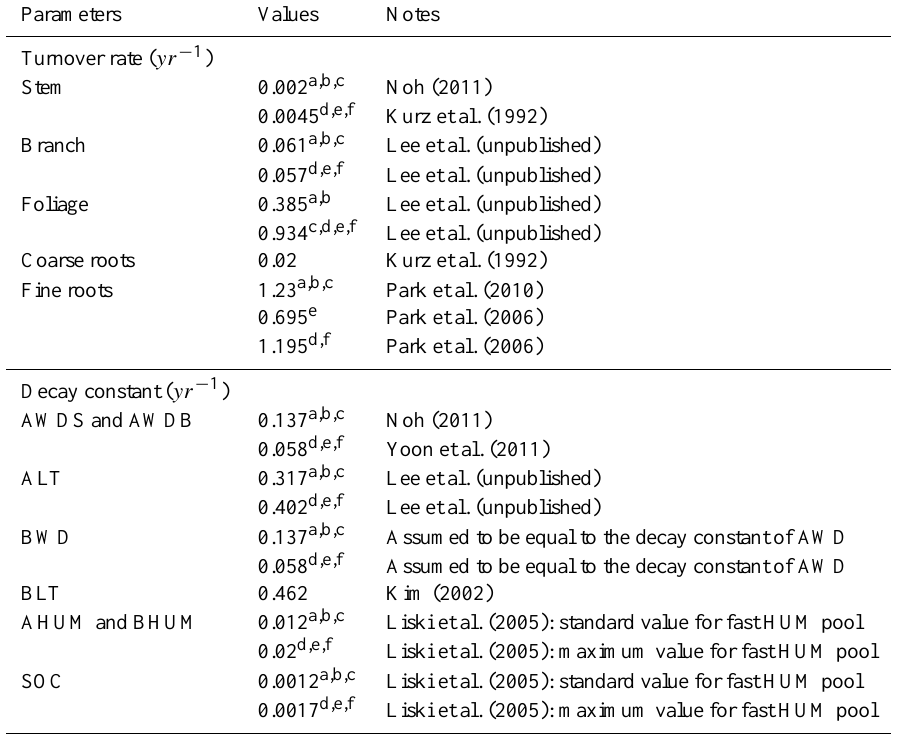
Table 1. Standard input parameter values for model simulation. The other parameters are the same as described by Yi et al. (2013). Parameters Values Notes